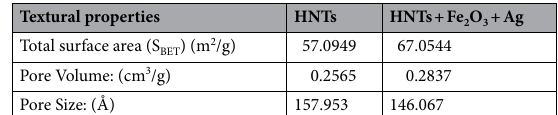
Table 1. Textural properties of raw and doped HNTs